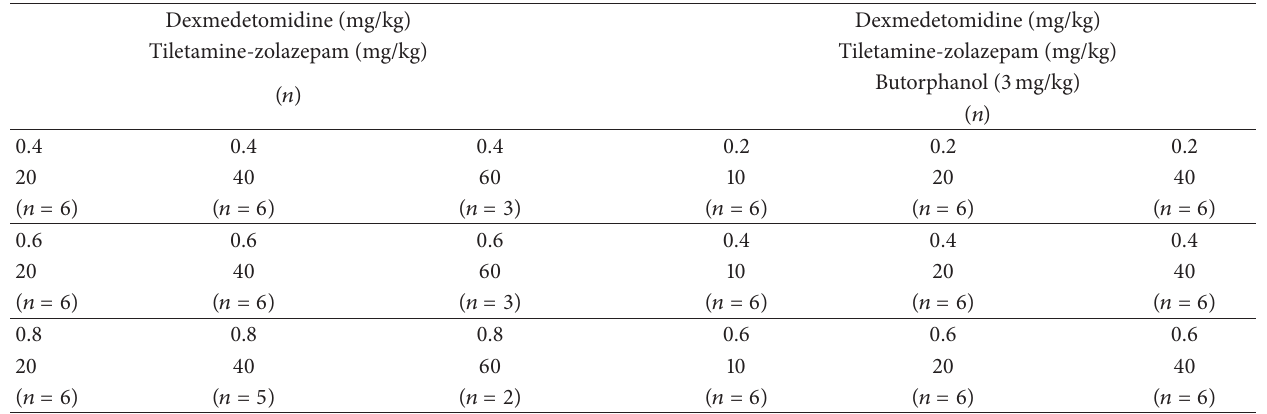
Table 1: Anesthetic combinations of dexmedetomidine and tiletamine-zolazepam with or without butorphanol. BALB/c female mice were assigned with the intent for six mice in each group, but, due to the high mortality associated with the use of tiletamine-zolazepam above 50 mg/kg, groups were reduced. Dexmedetomidine and tiletamine-zolazepam were given IP and butorphanol was given